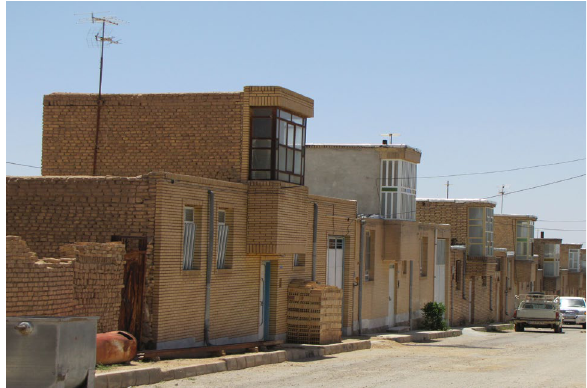
Figure 19. New texture of the village, author. 2.3.1 Girder and Zarbi vault: In this method, girders are placed on the bearer wall with an 80 to100 cm distance with each other. Then bricks and a combination of gypsum and soil, small vaults can be implemented between the girders. Finally, mud (Kah-gel 20 ) is used to flatten the roof. This vault is called Zarbi (like an in Figure10) because of the placement of the bricks, the 10×20 dimension of which is used (Pakcheshm, 2016) (Figure 20).